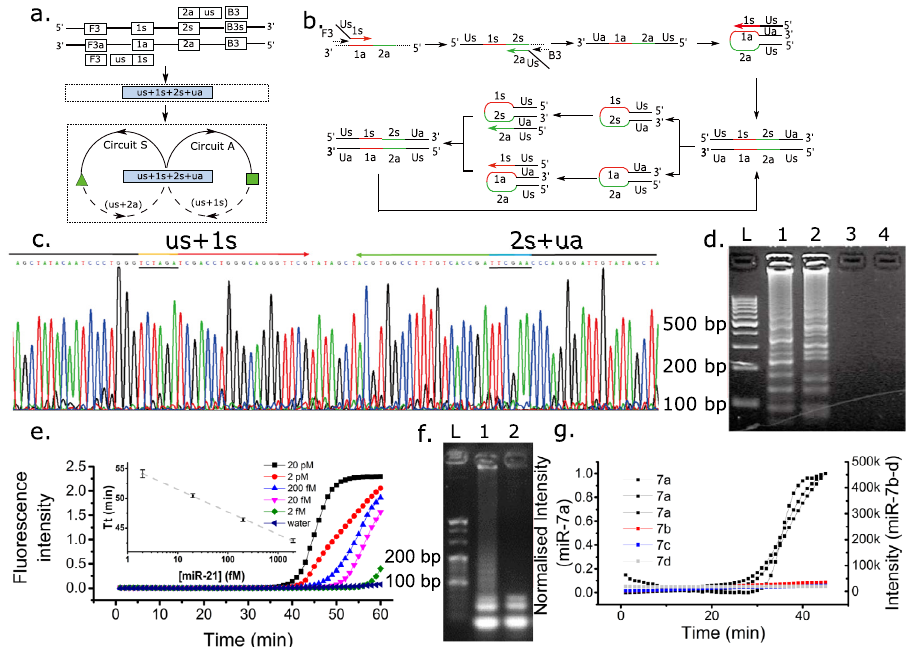
Fig. 3 Reaction graph of isothermal ampli fi cation with primers containing a generic 5 ′ termini. The functional hairpin structure (us + 1s + 2s + ua) is formed after the target is added, starting the ampli fi cation process. b The secondary structure mechanism of the process described in ( a ). The primers with the generic tails are 1s + Us and 2a + Us. c Sequencing of functional hairpin structure (us + 1s + 2s + ua). (TCTAGA) and (TTCGAA) were inserted into the primers as markers. d Effect of template concentration on ampli fi cation. Agarose gel electrophoresis of the products as a function of target concentration. L, ladder; lane 1, 40 M. tuberculosis cells; lane 2, 4 M. tuberculosis cells; lane 3, 0.4 M. tuberculosis cells; lane 4, buffer (45 min reaction). The gel is representative of experiments repeated independently three times with similar results. e , f Application to the detection of mir21 microRNA (sequence 1s2s). e Real-time ampli fi cation curves showing concentration dependant detection for 10× serial dilutions from 20 pM (orange) to 2 fM (light blue). Negative control shown in grey. Inset is average threshold time (Tt) for different concentrations of mir-21 ( n = 3 independent experiments, error bar is standard deviation) ( f ) Con fi rmation by gel electrophoresis: Lane 1 is 20 pM, 2 is blank (1 h reaction). The gel is representative of experiments repeated independently three times with similar results. g Speci fi city of the detection of miR-7 against other members of the family. (concentration: 100 fM). In black squares - three replicates of miR-7a; miR-7b (red); 5. miR-7c (grey); 6. miR-7d (blue). Left y -axis indicates the normalised ampli fi cation signal of miR-7a, while the right y -axis applies to the ampli fi cation signal of other microRNAs. Source data are provided as a Source Data fi